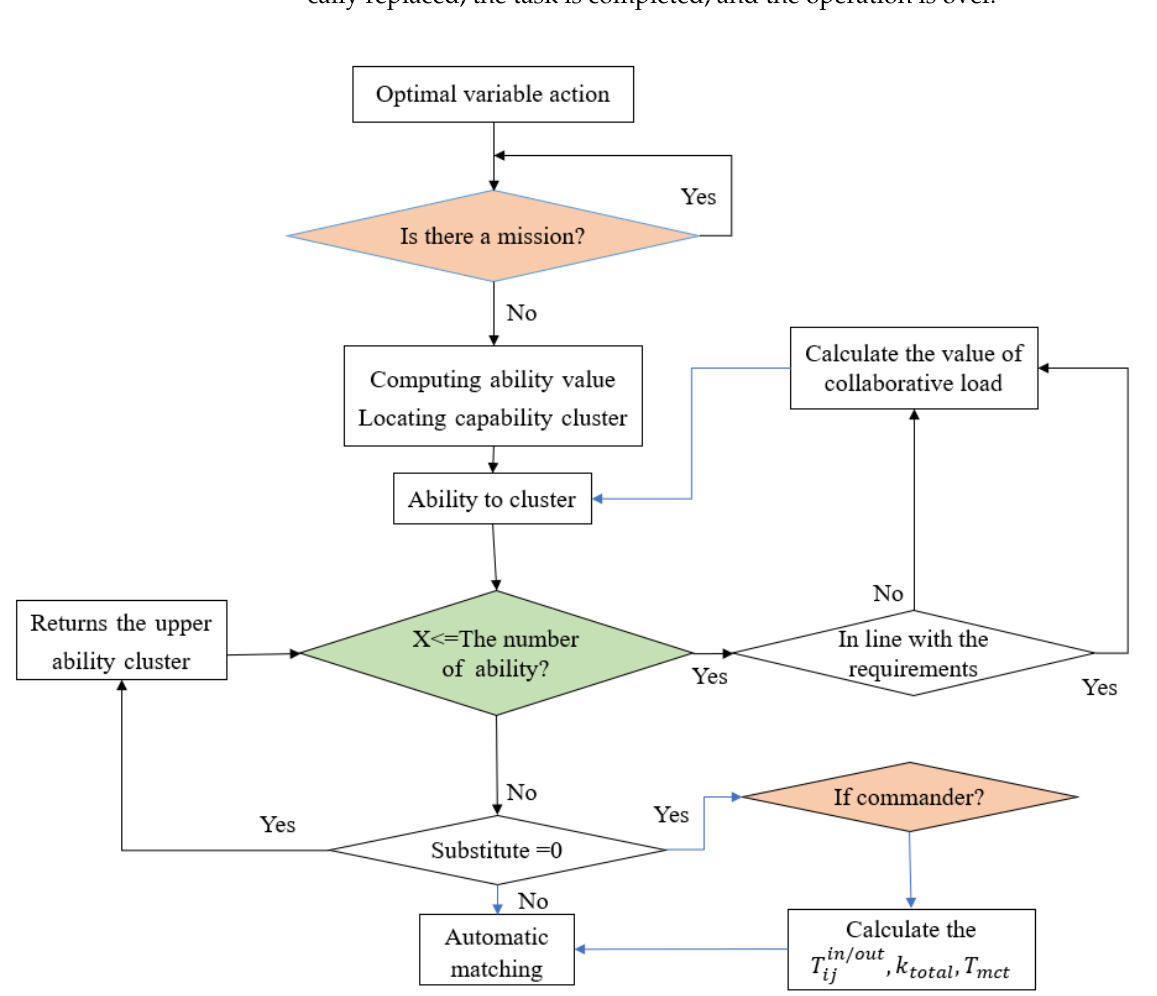
Figure 5. Scheduling algorithm of